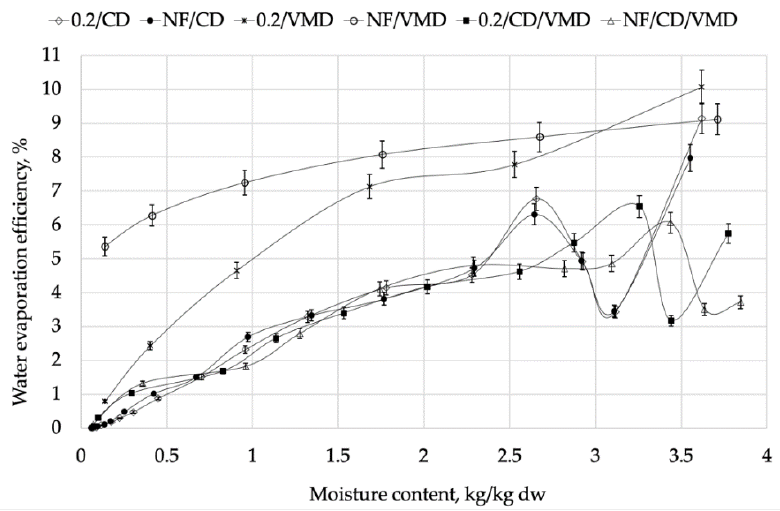
Figure 3. Energy efficiency during drying using different methods.